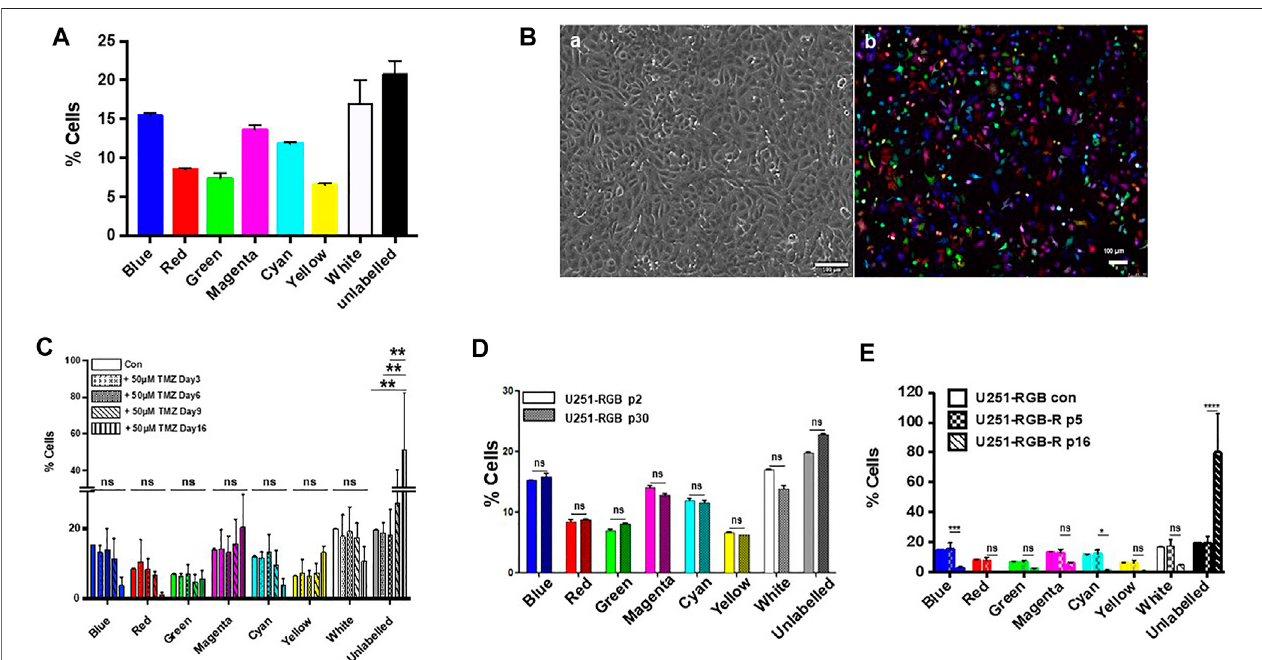
FIGURE2|(A) FACSanalysisofU251-RGBcellsatpassagetwoshowingthedistributionofthedifferentcoloredpopulations. (B) ImagesofU251-RGBcellsunder phase contrast (A) and under confocal microscopy (B) . (C) FACS analyses of untreated U251-RGB cells or cells treated for 3, 6, 9, and 16 days with 50 µM TMZ. No signi fi cant statistical differences were found between the different samples (days of treatment) except for day 16 which shows an increase in unlabeled cells. (D) FACS analyses of U251-RGB cells at passage 2 (p2) and passage 30 (p30); the latter passage corresponds to 5 months in culture without TMZ. (E) FACS analyses of U251-RGB cells vs. U251-RGB resistant cells at passage 5 (p5) and passage 16 (p16). This suggests that acquisition of resistance is accompanied by a loss in labeled cells. All statistical analyses were obtained from experiments performed at least three times.